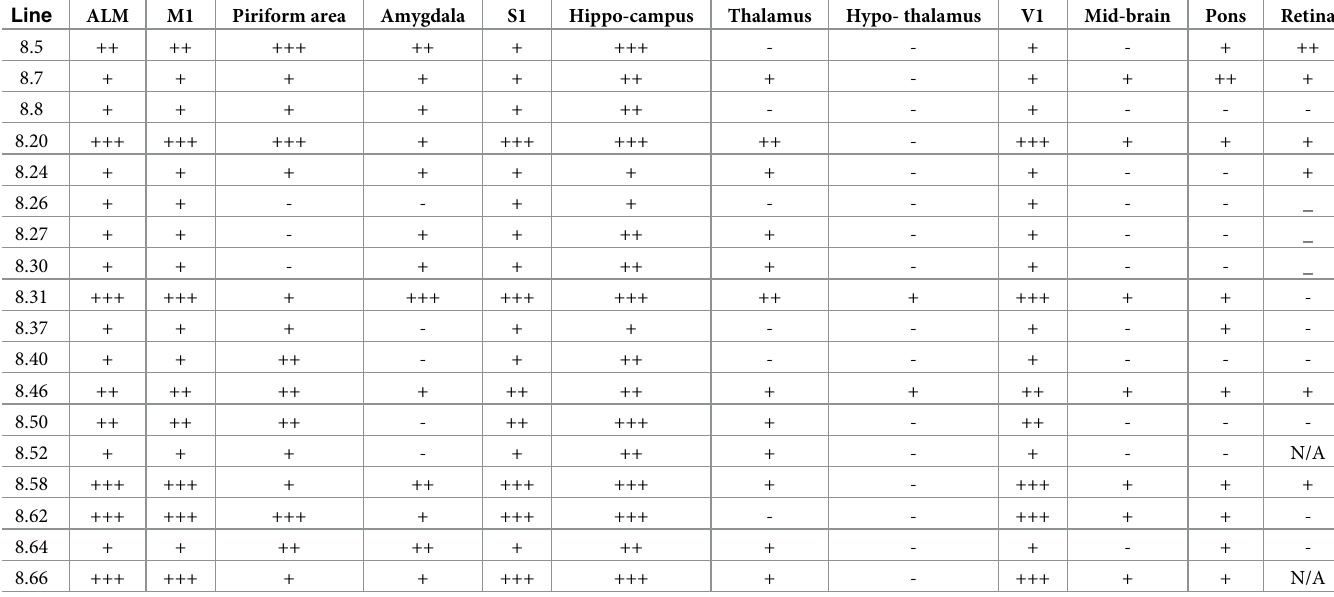
Table 1. Brain wide jRGECO1a expression of multiple GP